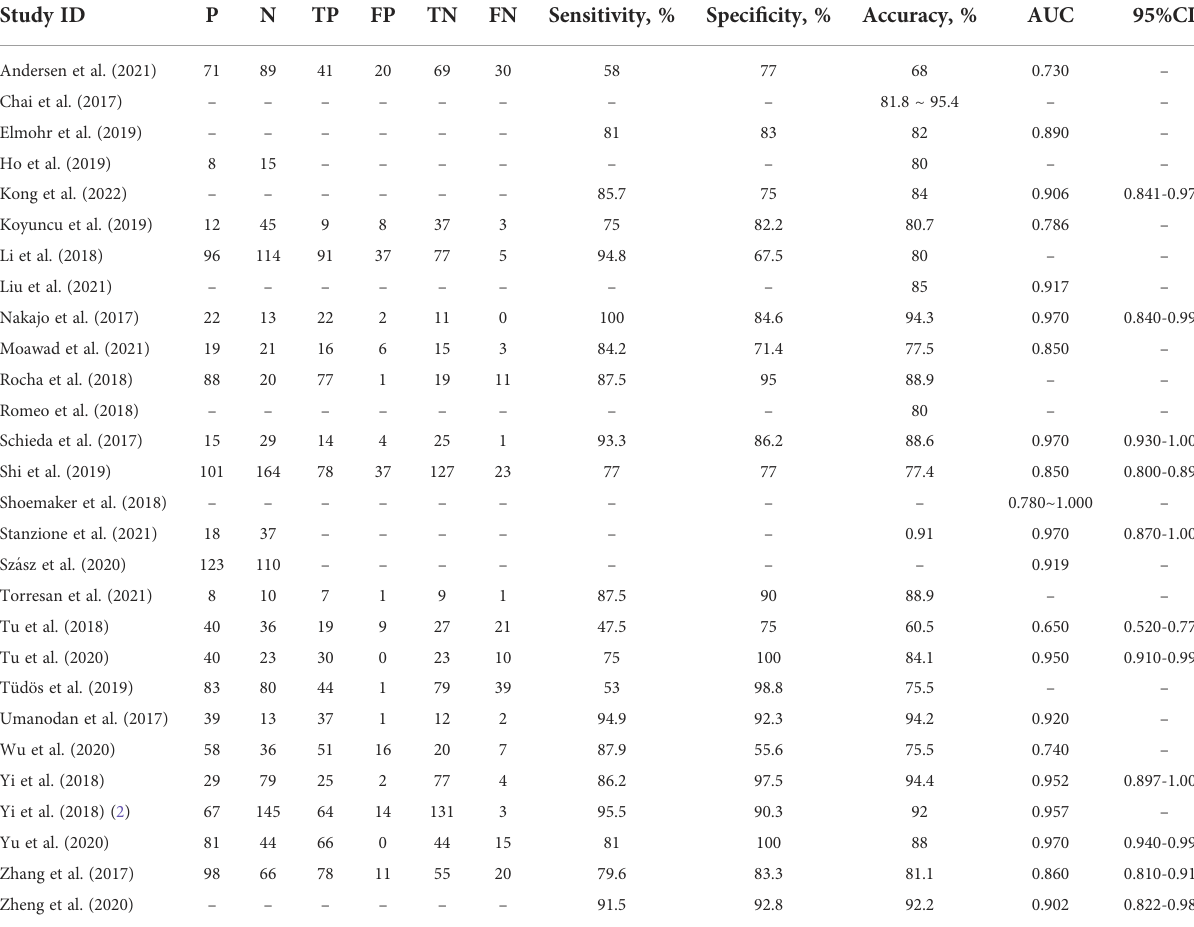
TABLE 2 Outcomes of the included